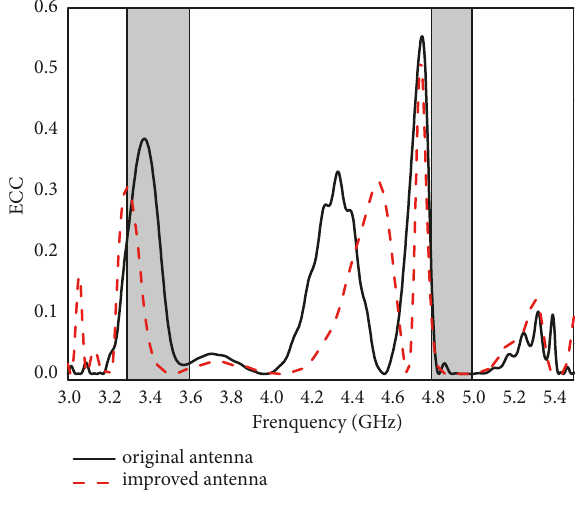
Figure 10: Envelop correlation